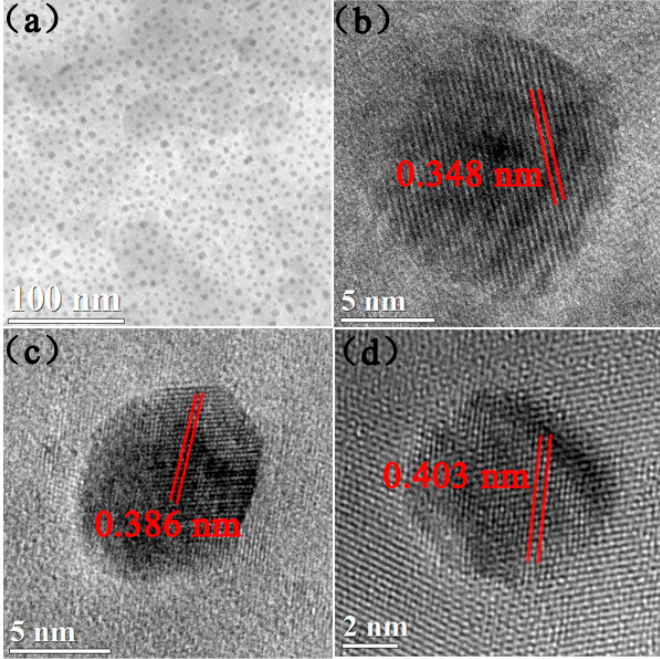
Figure 4. ( a )The top-view TEM images of the samples: 3 # ; the HRTEM images of samples: ( b ) 1 # ; ( c ) 3 # and ( d ) 5 # .